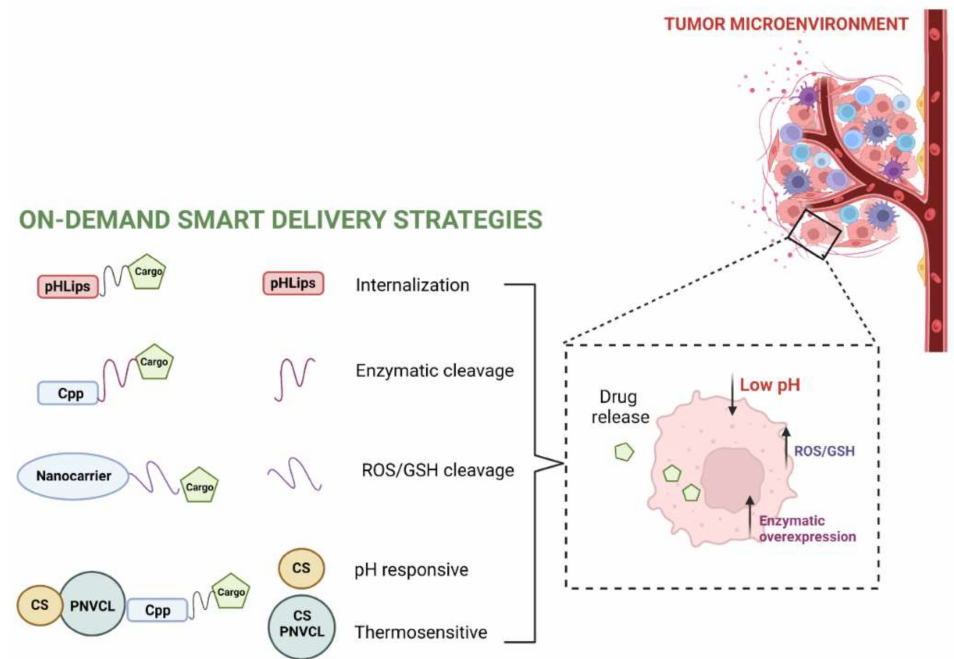
Figure 3. Illustration of different on-demand delivery strategies exploited for achieving a stimuli- responsive drug release from peptide-based NVs in the tumor environment. This figure was created with BioRender.com (accessed on 2 February